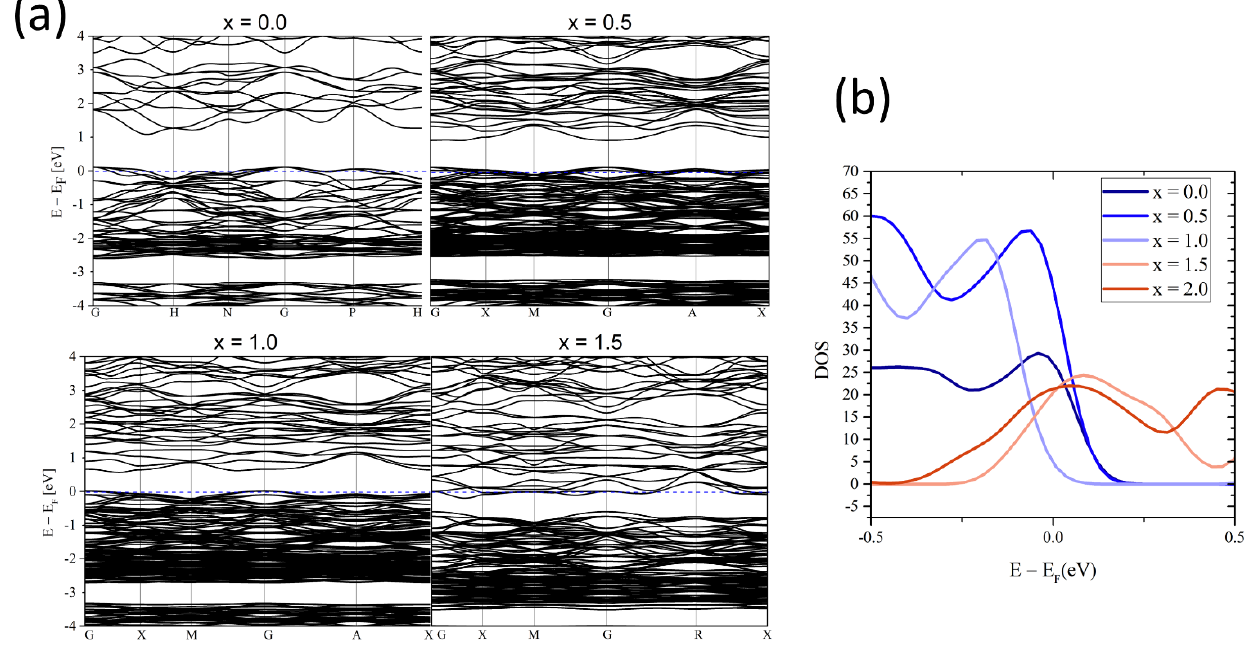
Figure 5. Calculated electronic band structures ( a ) and density of states ( b ) for Mg x Cu 12 Sb 4 S 13 .